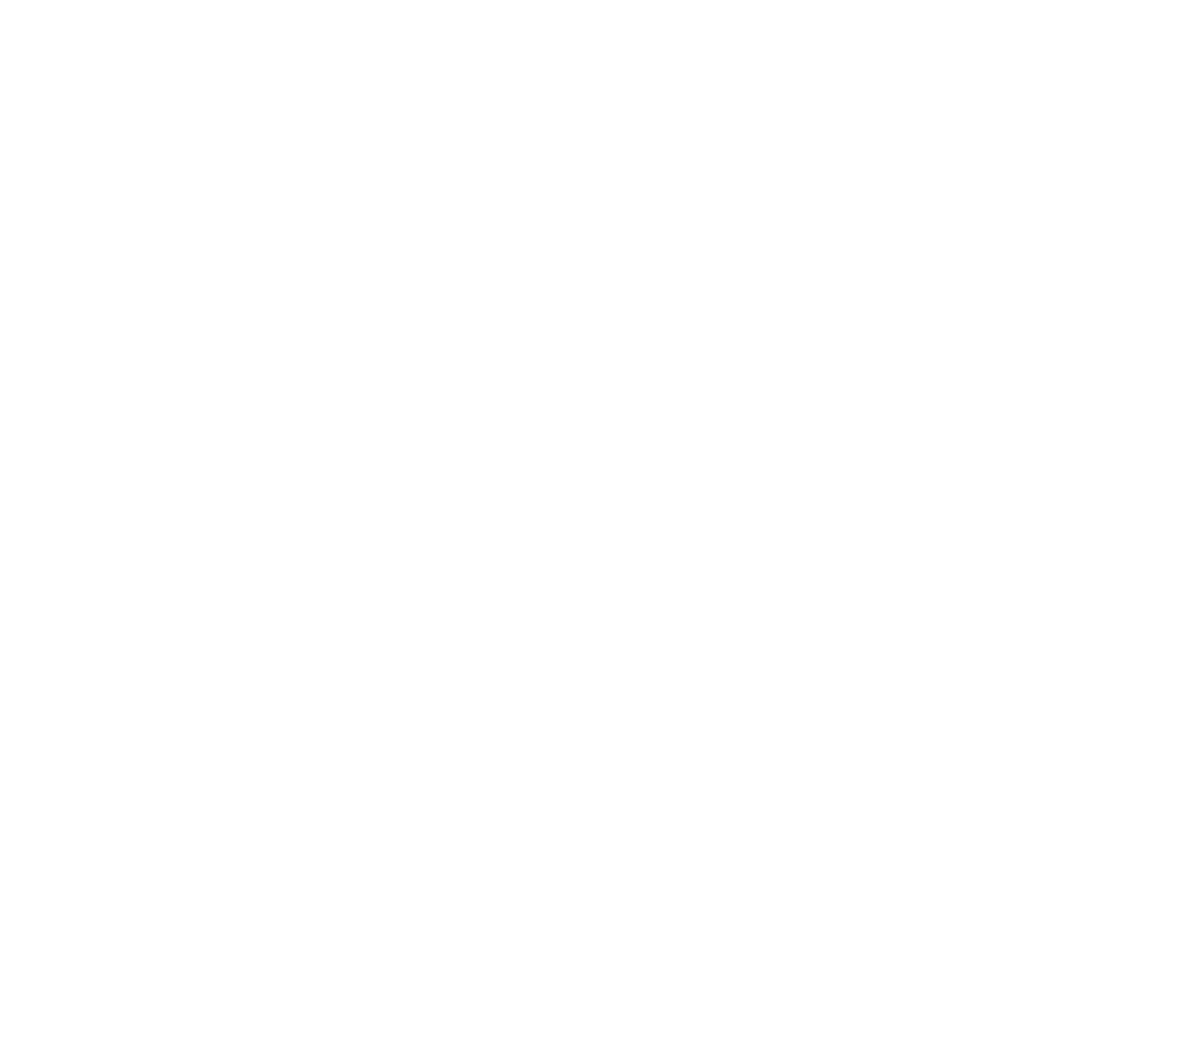
Frontiers in Pharmacology |